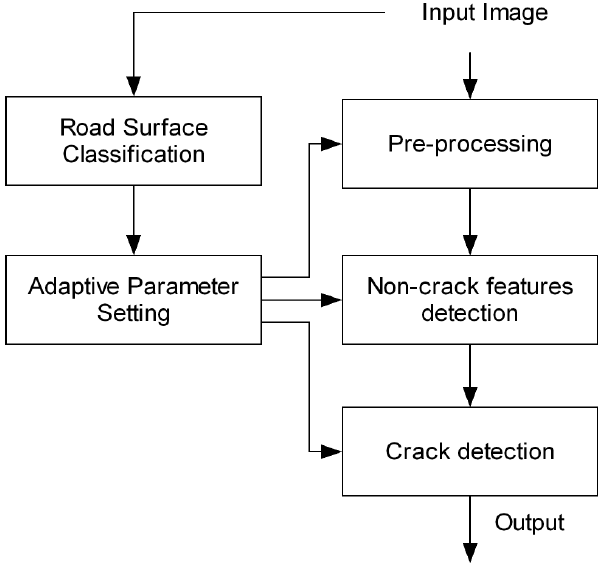
Figure 2. Global overview of the proposed adaptive road distress detection system that is divided into four main stages: road surface classification , pre-processing , non-crack features detection , and crack detection . The output of the classifier is used to adapt the system